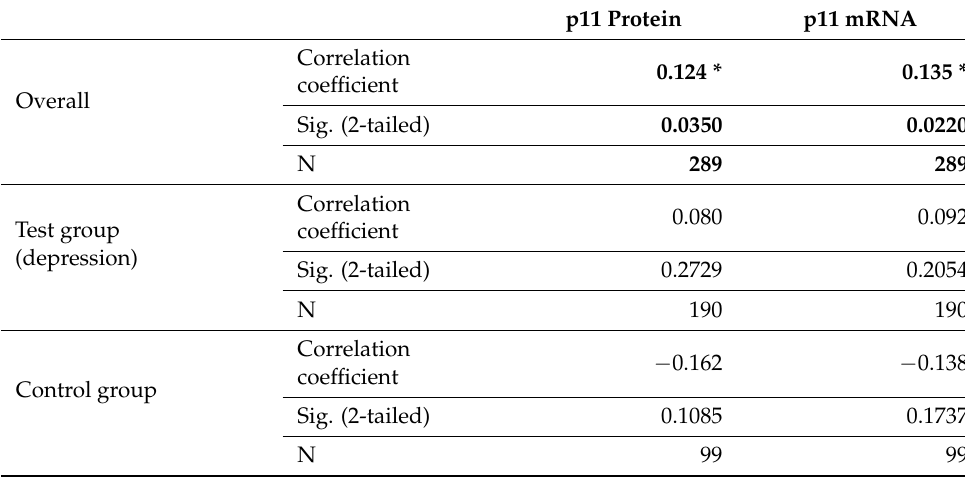
Table 4. Correlation of p11 gene expression with age (by study